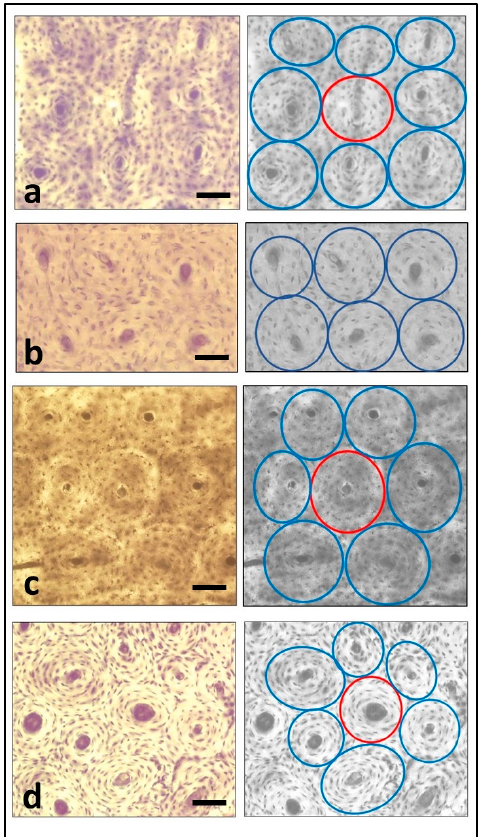
Figure 2. Dense Haversian tissue. ( Left ) Original microphotos; ( right ) osteons are highlighted with circles to evaluate the common points with neighboring osteons. ( a , b ) H 2 subtype, where each osteon is in contact with 4 other osteons (( a ) Capra hircus ; ( b ) Sus scrofa ). ( c , d ) H 3 subtype, where each osteon is in contact with 6 other osteons (( c ) Ovis musimon ; ( d ) Equus caballus ). The circles correspond to osteons. In H 3 subtype an osteon (red circle) is surrounded by 6 osteons (blue circles). Bar = 40 µm.